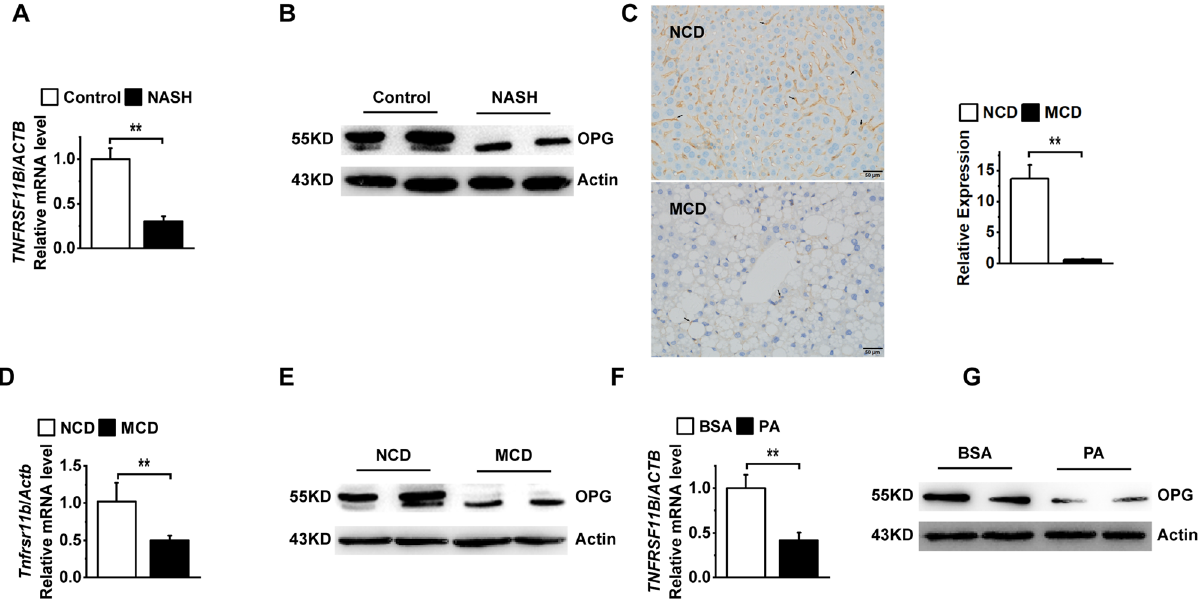
Figure 1. Osteoprotegerin (OPG) expression is downregulated in nonalcoholic steatohepatitis (NASH). ( A ) TNFRSF11B mRNA expression in the livers of patients with NASH. ( B ) OPG protein levels in the livers of patients with NASH. ( C ) Expression levels of OPG in liver tissues from methionine- and choline-deficient (MCD) diet-induced NASH animal model. Scale bars: 50 μm. OPG are shown by arrows. Graph showing comparisons of OPG expression in liver tissues from control or MCD diet-induced mice. ( D ) Tnfrsf11b mRNA expression in the livers of the methionine- and choline-deficient (MCD) diet-induced NASH animal model. ( E ) OPG protein levels in the livers of the MCD-induced NASH animal model. ( F ) TNFRSF11B mRNA expression in the PA-induced NASH cell model. ( G ) OPG protein levels in the PA-induced NASH cell model. Each group at least has 3 samples. The data in ( A ), ( C ), ( D ), and ( F ) are presented as the mean ± SD, **p <